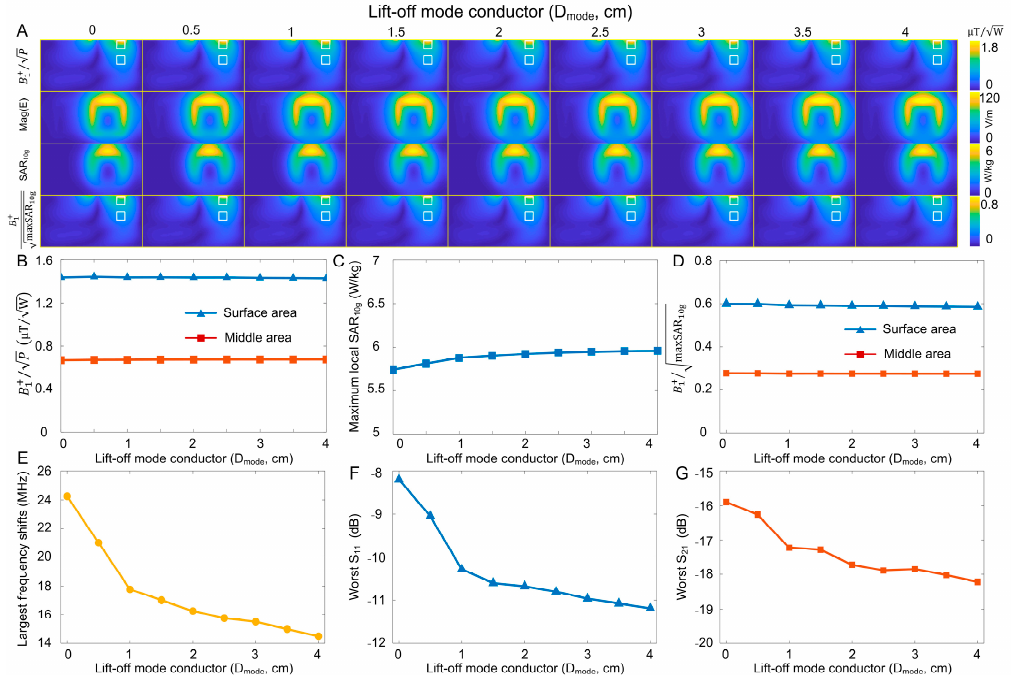
Figure 3. ( A ): Simulated B 1+ efficiencies, E-fields, local SARs, and B 1+ SAR efficiencies of self-decoupled coils with different lift-off distances of the mode conductor (D mode ). ( B – D ): Plots of average B 1+ efficiencies ( B ), maxSAR 10g ( C ), and average B 1+ SAR efficiencies ( D ) versus D mode at the surface and middle areas. ( E ): Largest resonant frequency shift (compared to 298 MHz) of self-decoupled coils with different D mode . ( F , G ): Worst S 11 ( F ) and worst S 21 ( G ) of self-decoupled coils when moving the coil closer or further away from the phantom.